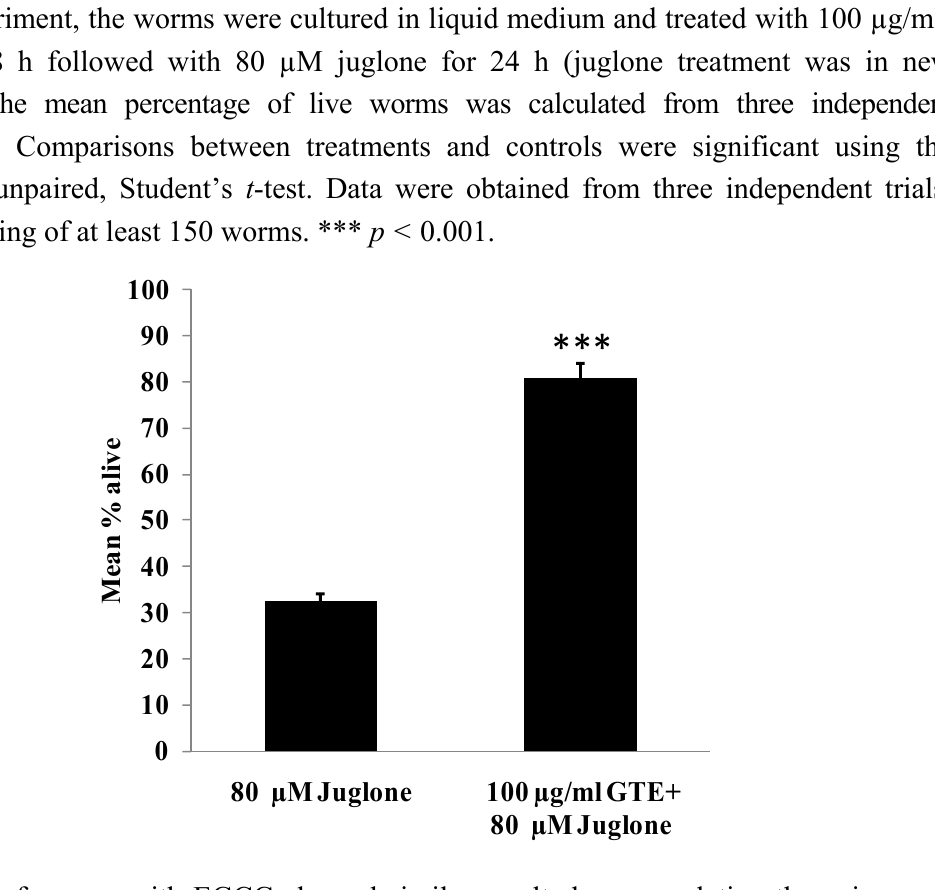
Figure 5. Survival rates of wild-type C . elegans under an acute lethal dose of